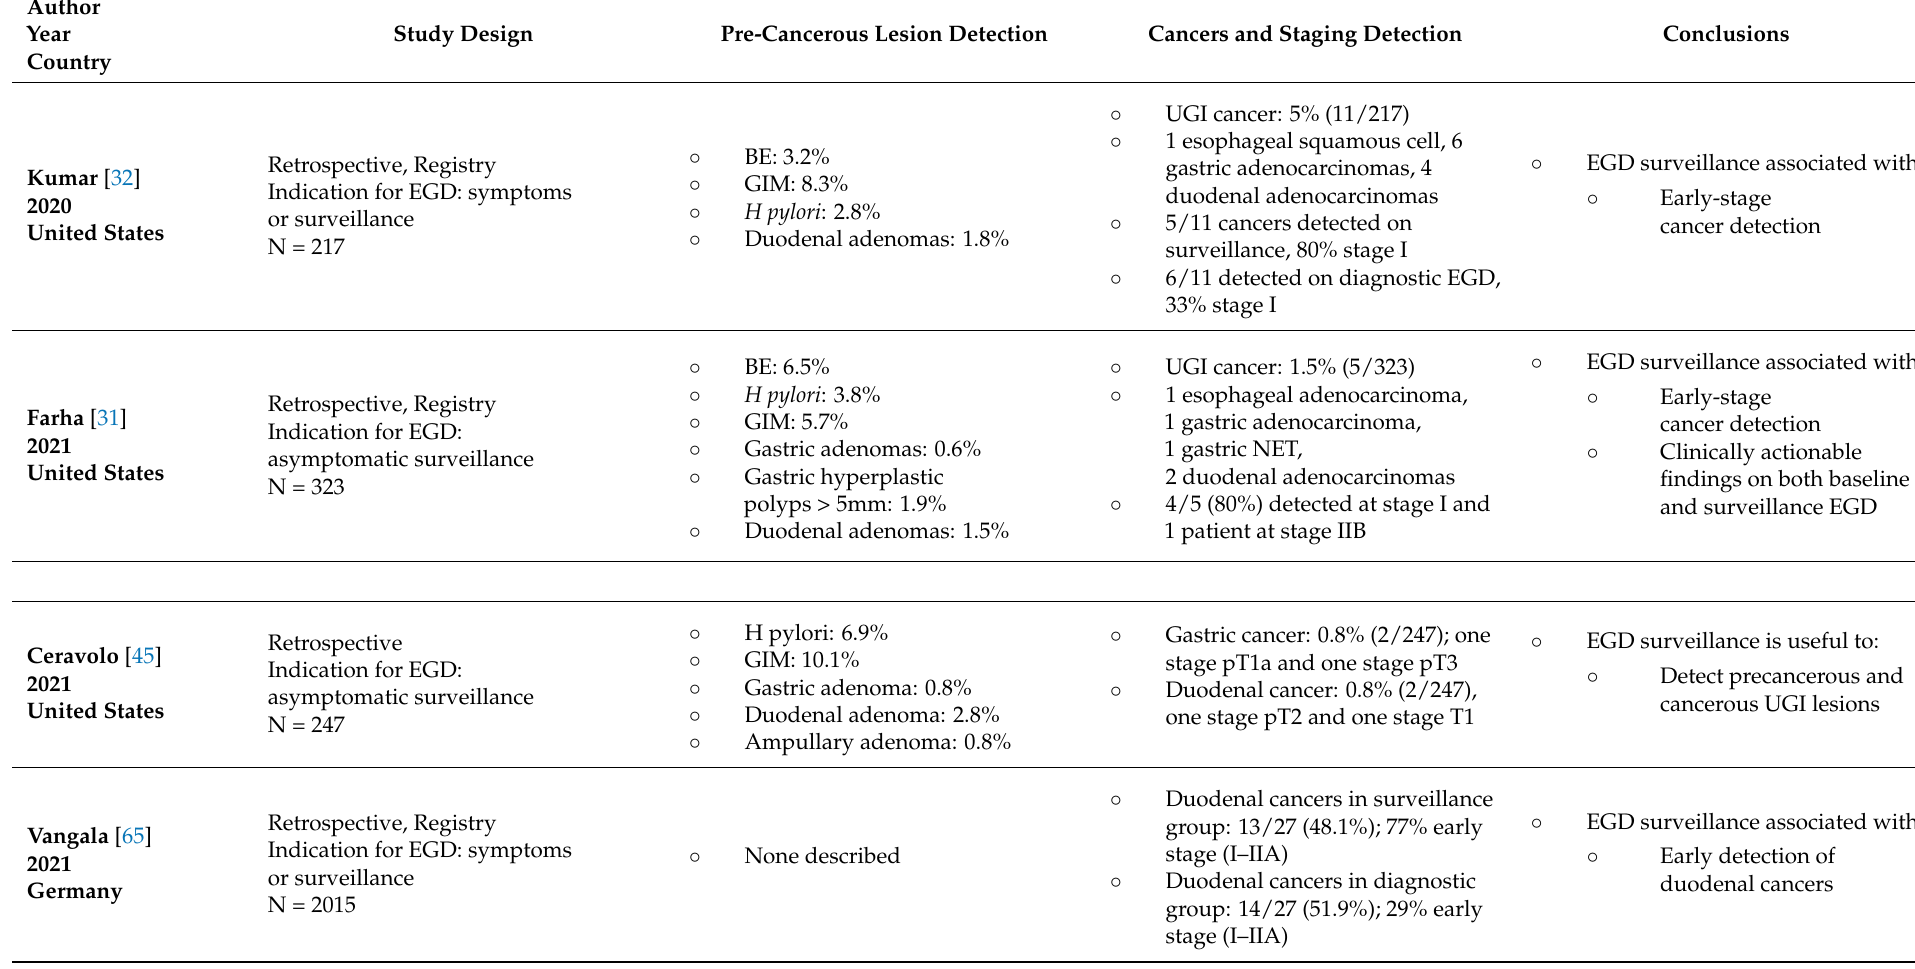
Table 3. Studies evaluating surveillance of UGI cancer in Lynch